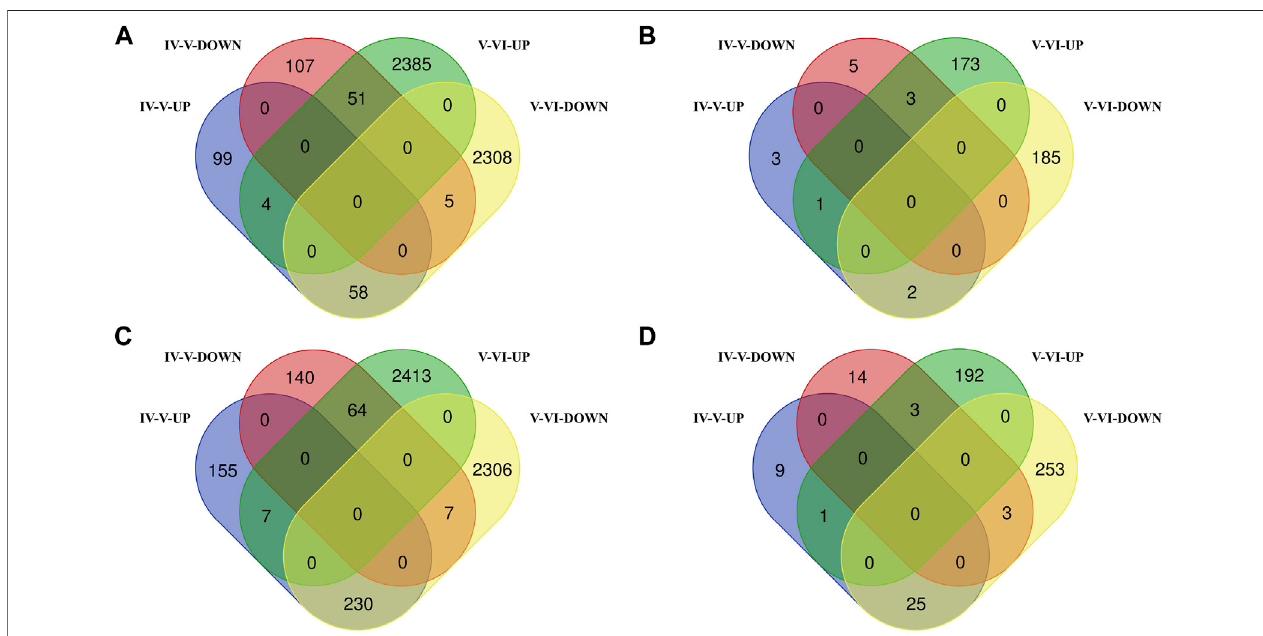
FIGURE 2 | Venn diagram of DE mRNA (A) and lncRNA (B) statistics in the brain. Venn diagram of DE mRNA (C) and lncRNA (D) statistics in the pituitary.